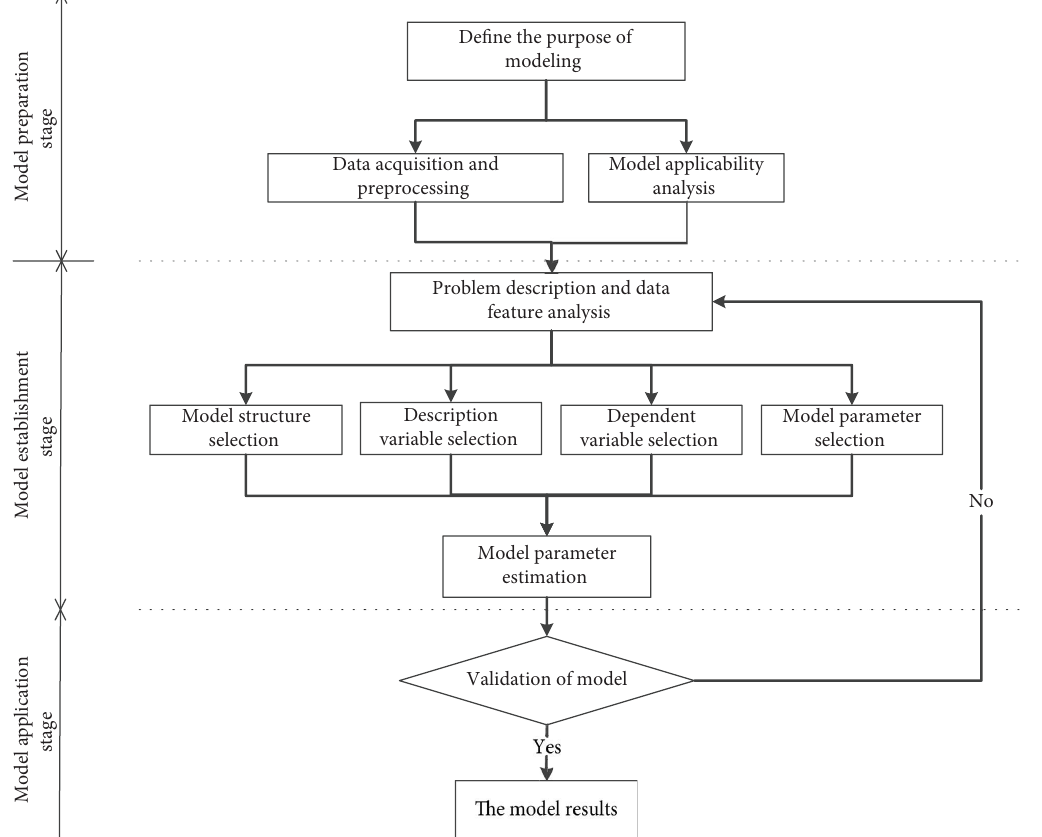
Figure 3: Framework and process of highway crash risk forecasting